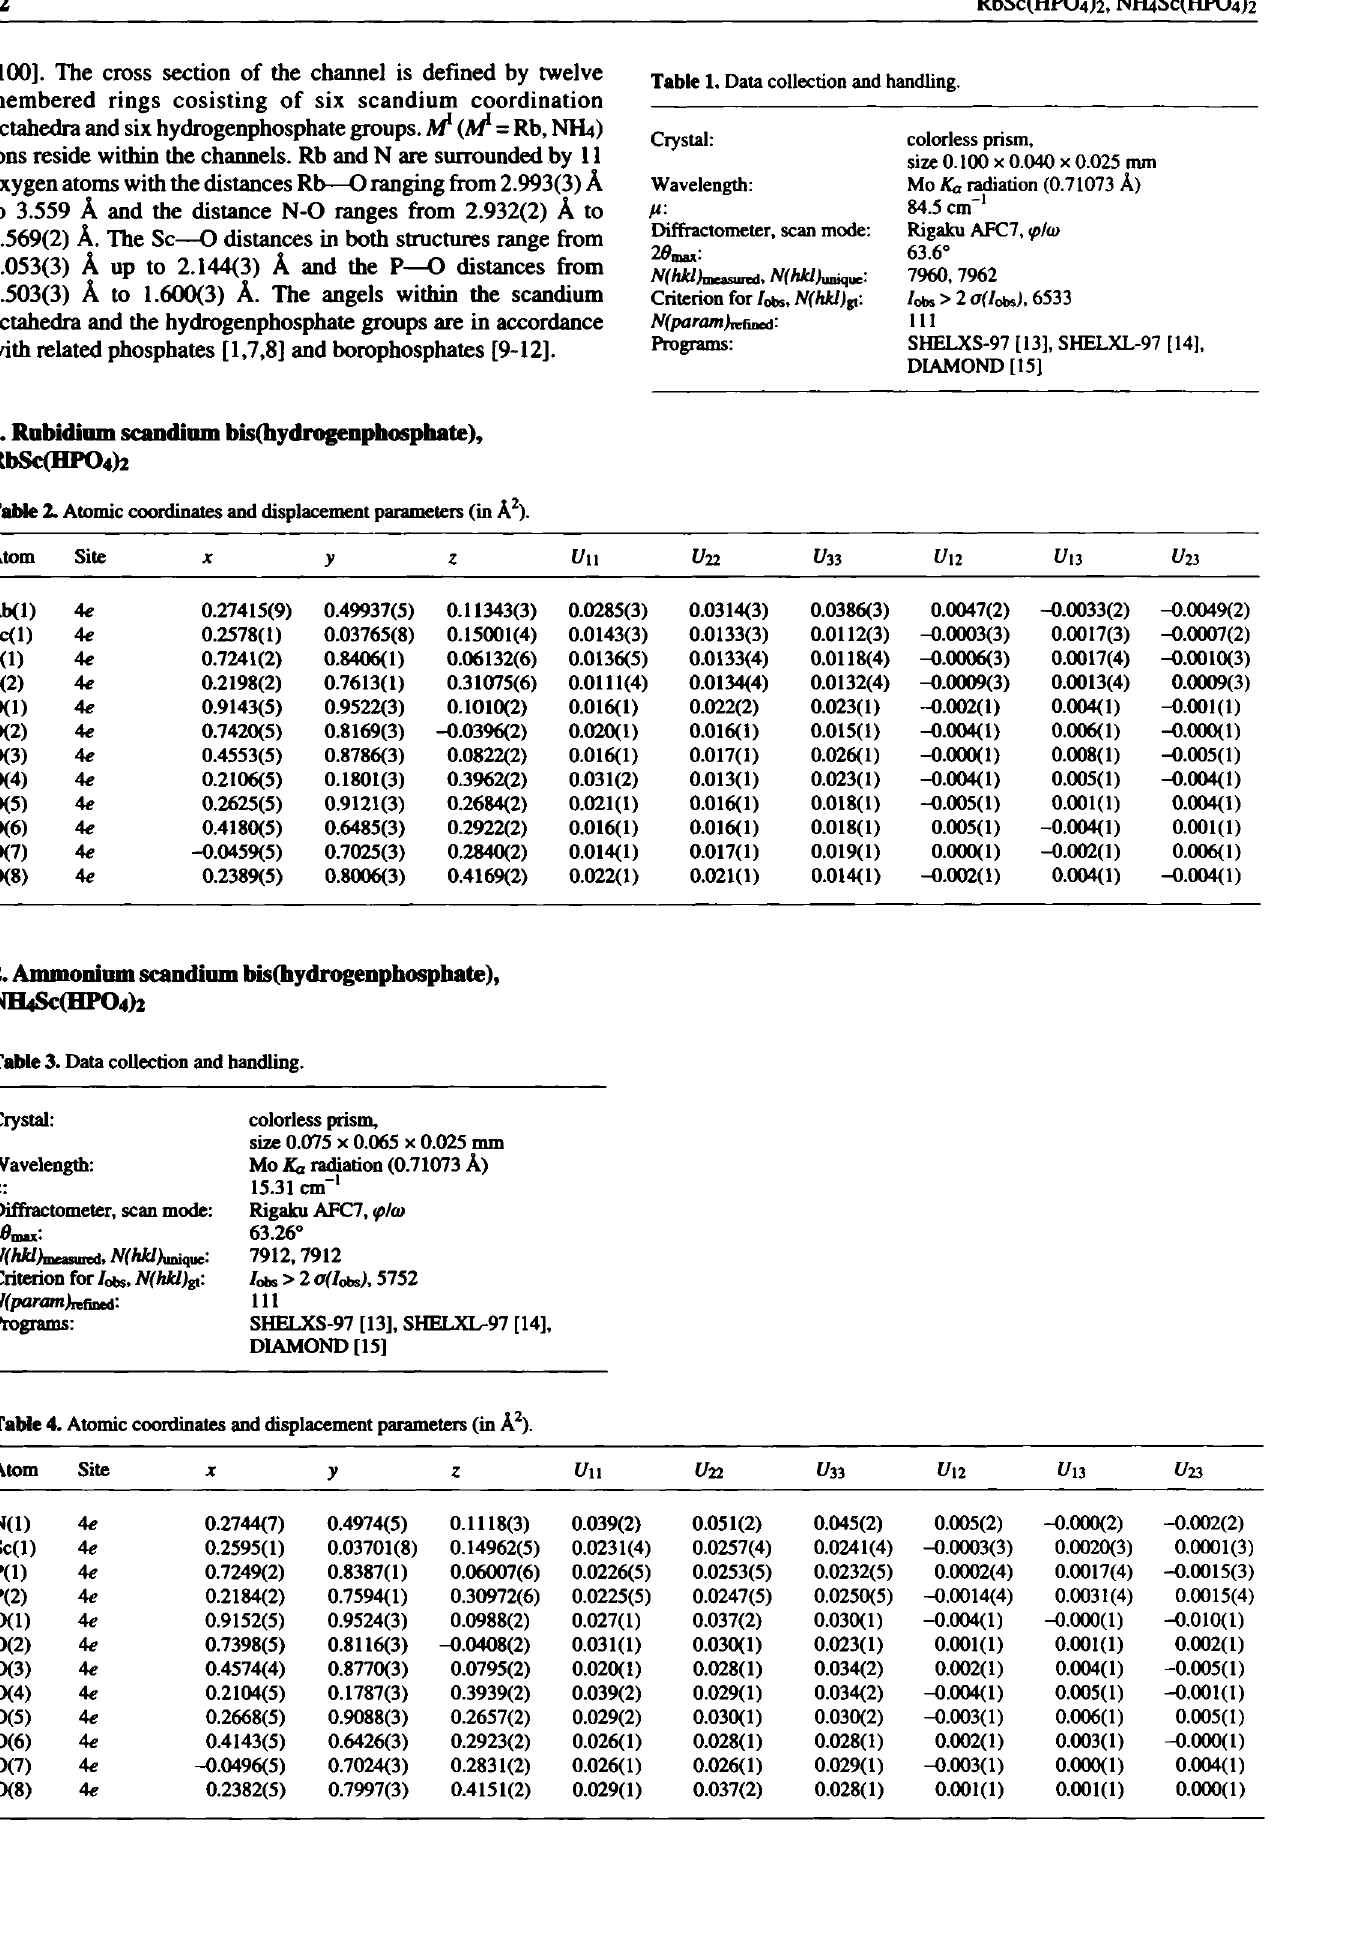
Table 1. Data collection and handling.